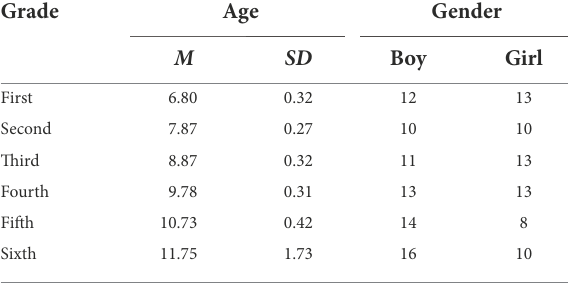
TABLE 1 Mean ( M ) and standard deviation ( SD ) descriptive of the age variable and frequency distribution of the gender variable by grade.